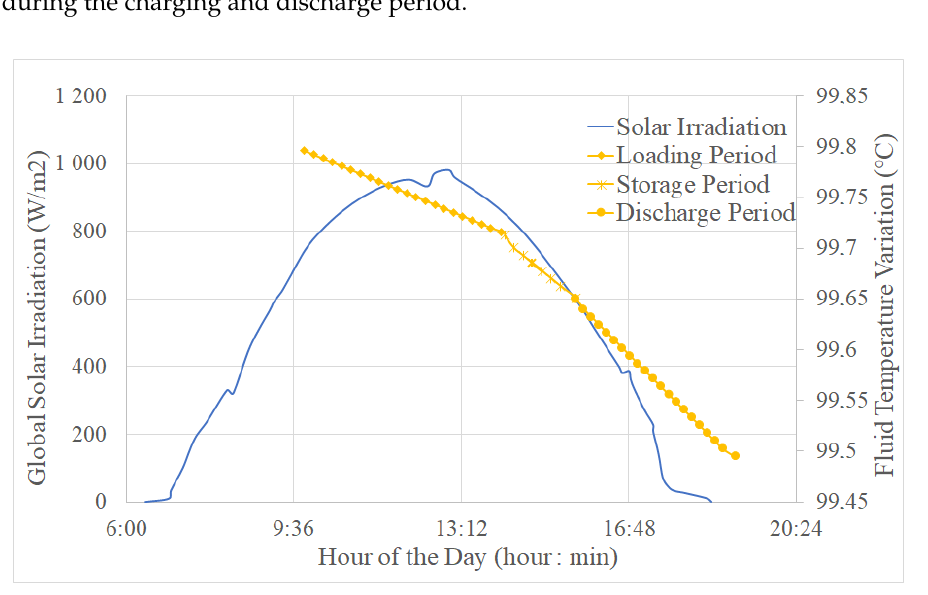
Figure 10. Variation in fluid temperature during the charging, storage, and discharge period of the storage tanks.